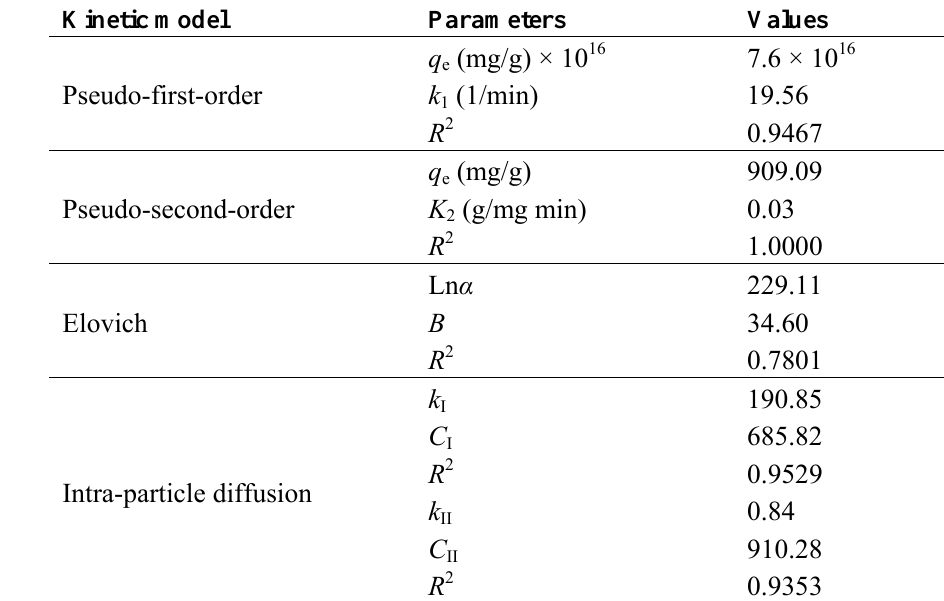
Table 1. Parameters of four kinds of kinetic